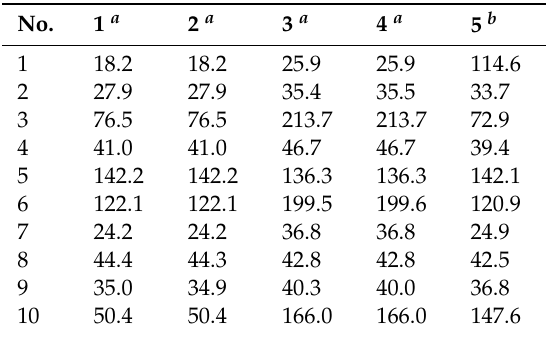
Table 2. 13 C NMR spectroscopic data for Compounds 1 – 5